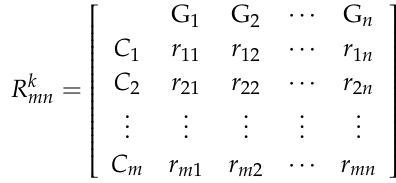
Table 2. Criteria of grading index for eutrophication of lake.